Question: Describe this figure in one sentence.
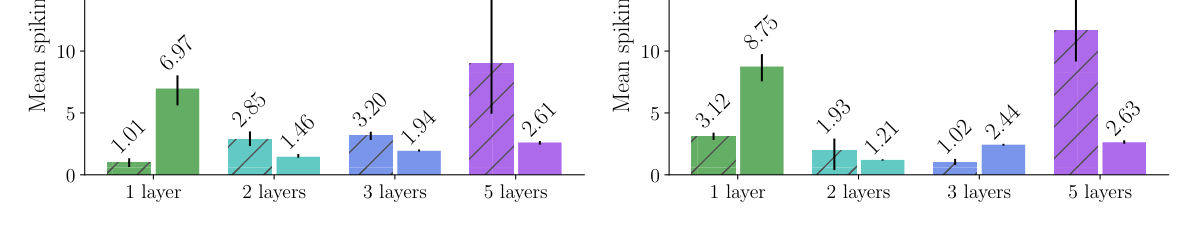
Answer: Mean spiking activity on the test set of the MNIST dataset with rate-based coding (left) and latency-based coding (right).